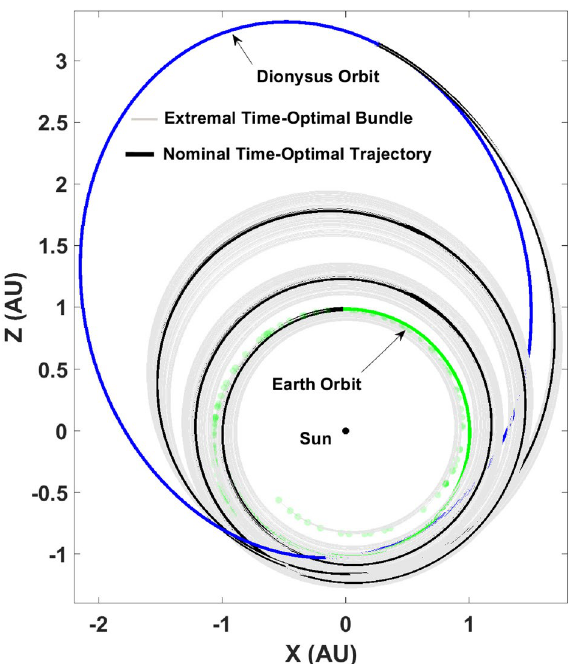
Figure 3. Time-optimal extremal bundle generated using TETA: N